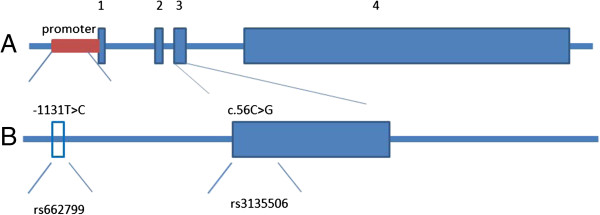
Maps of the human APOA5 gene with polymorphism positions indicated. (A) Map of the human APOA5 gene. Exons 1-4 are numbered and represented by solid boxes. (B) Position of the single nucleotide polymorphism within the core promoter of the APOA5 gene, a T/C polymorphism at position -1131 and a C/G polymorphism at position 56.